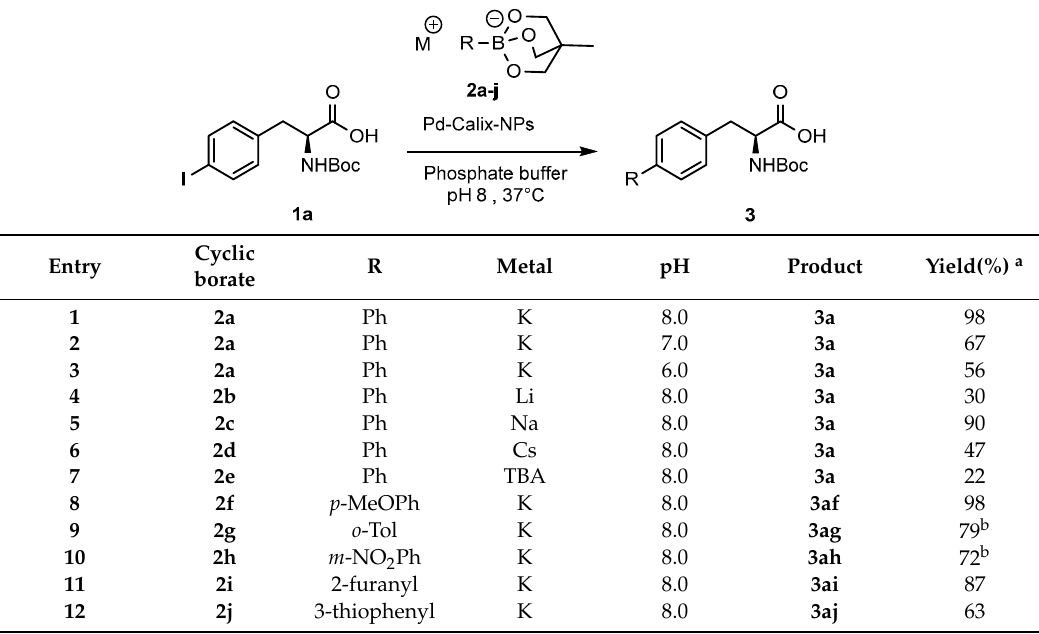
Table 4. Reactivity of aryl and heteroaryl cyclic triolborates with N -Boc-4-iodophenylalanine.